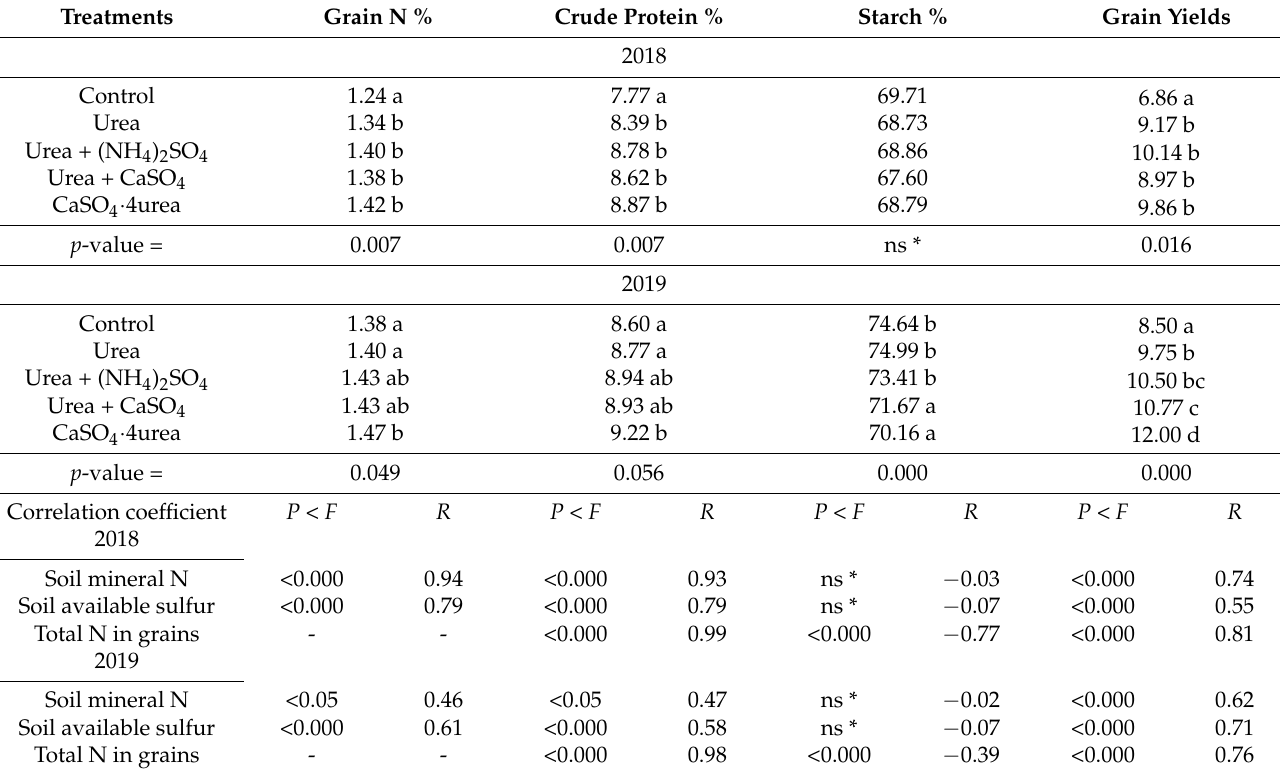
Table 5. Analysis of variance for the quality of the grain listed in total N, crude protein (%), starch (%) contents, and grain yields, including a summary of correlation relationships between these variables and soil mineral N and sulfur content for the 2-year study (2018–2019).